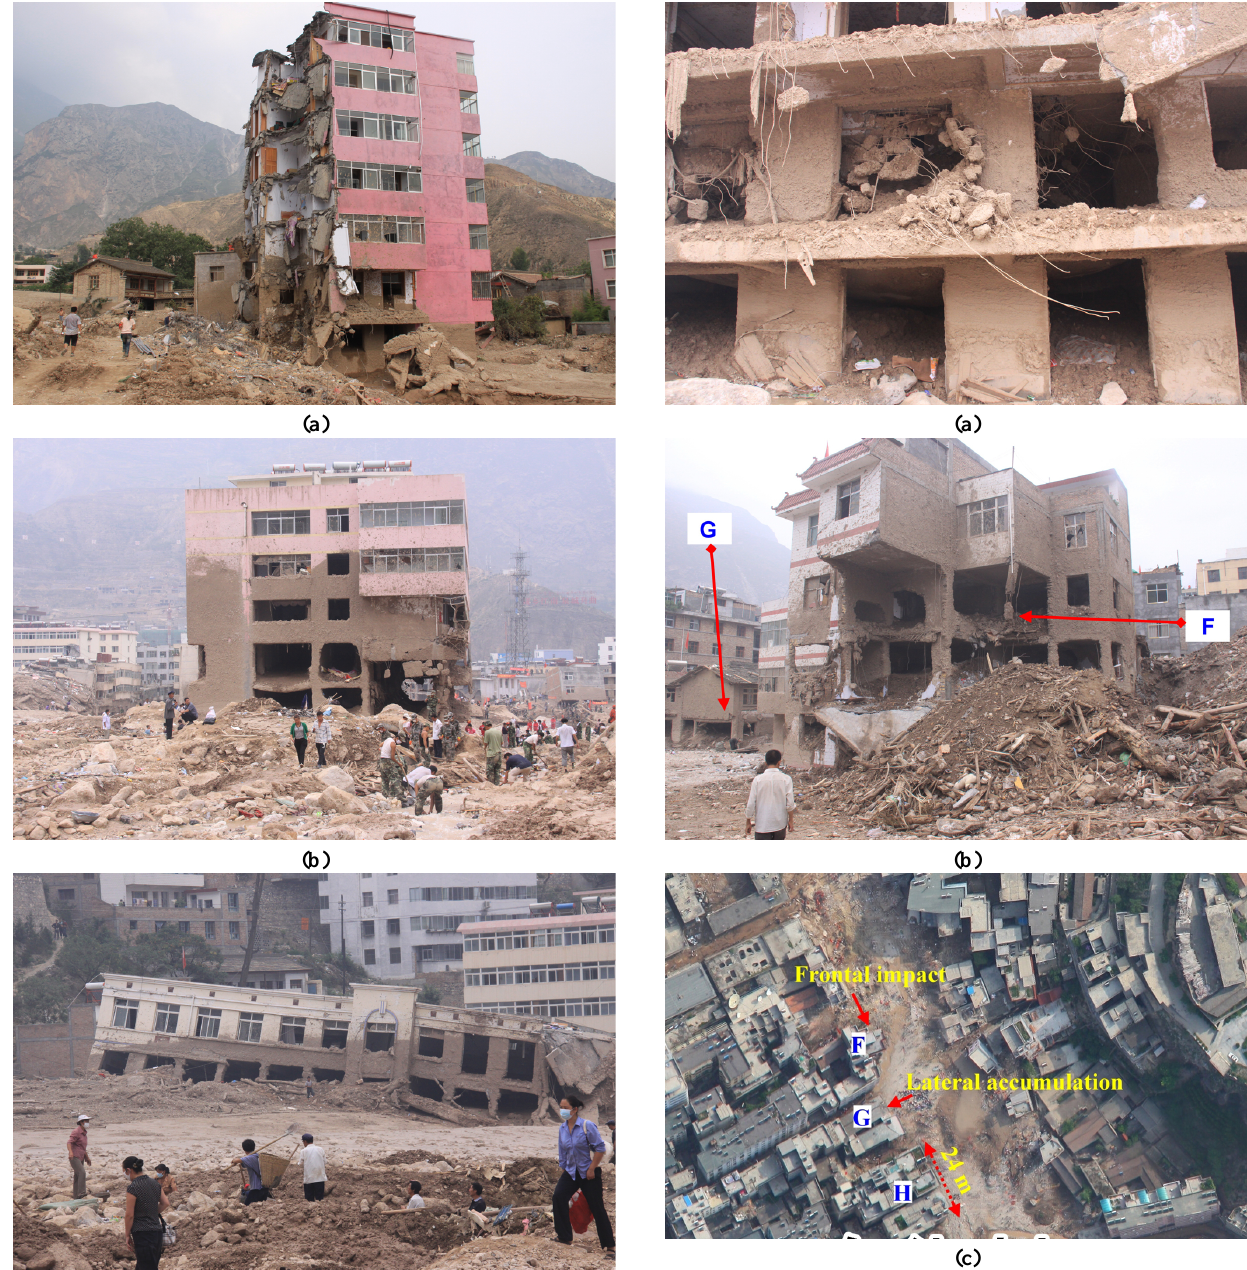
Fig. 3. Damage to the three buildings impacted head-on by proxi- mal debris flow. (a) Building A. (b) Building B. (c) Building E. One storey is approximately 3-m high.